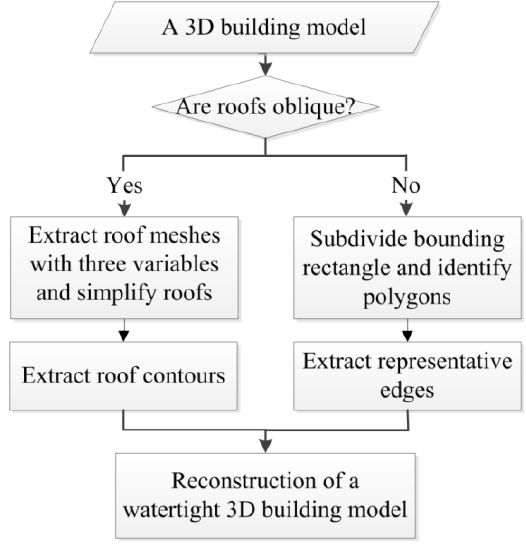
Figure 1. Flowchart of the integrated simplification approach for 3D buildings.